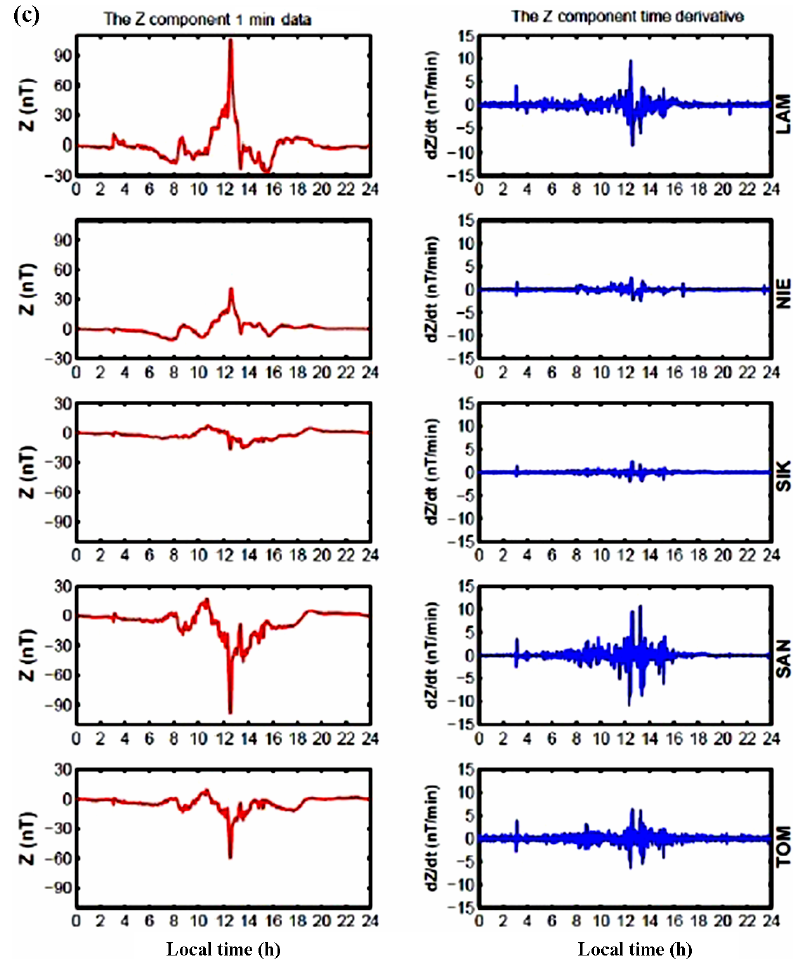
Figure 4. Geomagnetic field variations during the 17 February 1993 storm. Variations in the H (panel a ), D (panel b ) and Z (panel c ) component and its time derivative d Z/ d t at LAM, NIE, SIK, SAN and